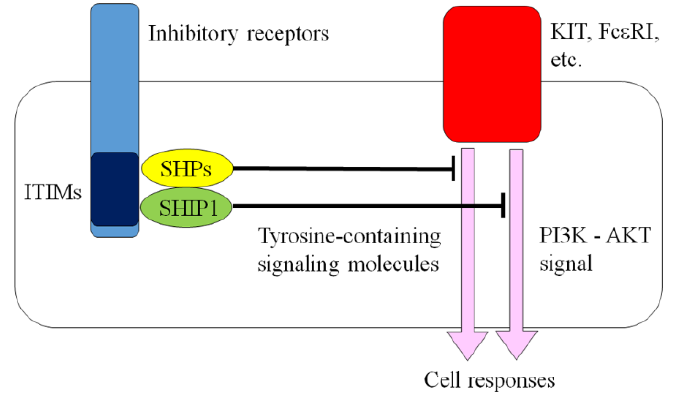
Figure 1. Inhibitory receptor. ITIM: immunoreceptor tyrosine-based inhibitory motif; PI3K: phosphatidylinositol 3-kinase; SHIP: Src homology 2 domain-containing inositol 5-phosphatase; SHP: Src homology 2 domain-containing tyrosine phosphatase.